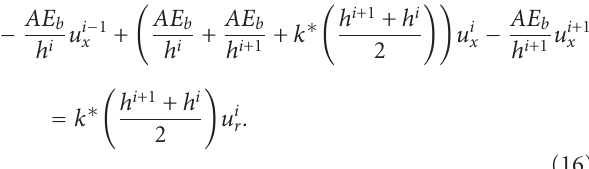
Discretized point on the bolt Figure 4: Finite di ff erence scheme and